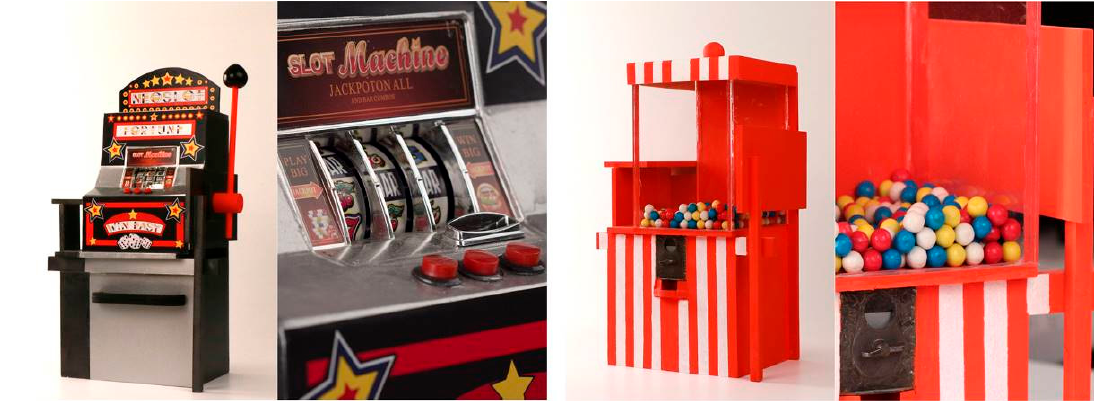
Figure 5. The Berlin chair transformed into a